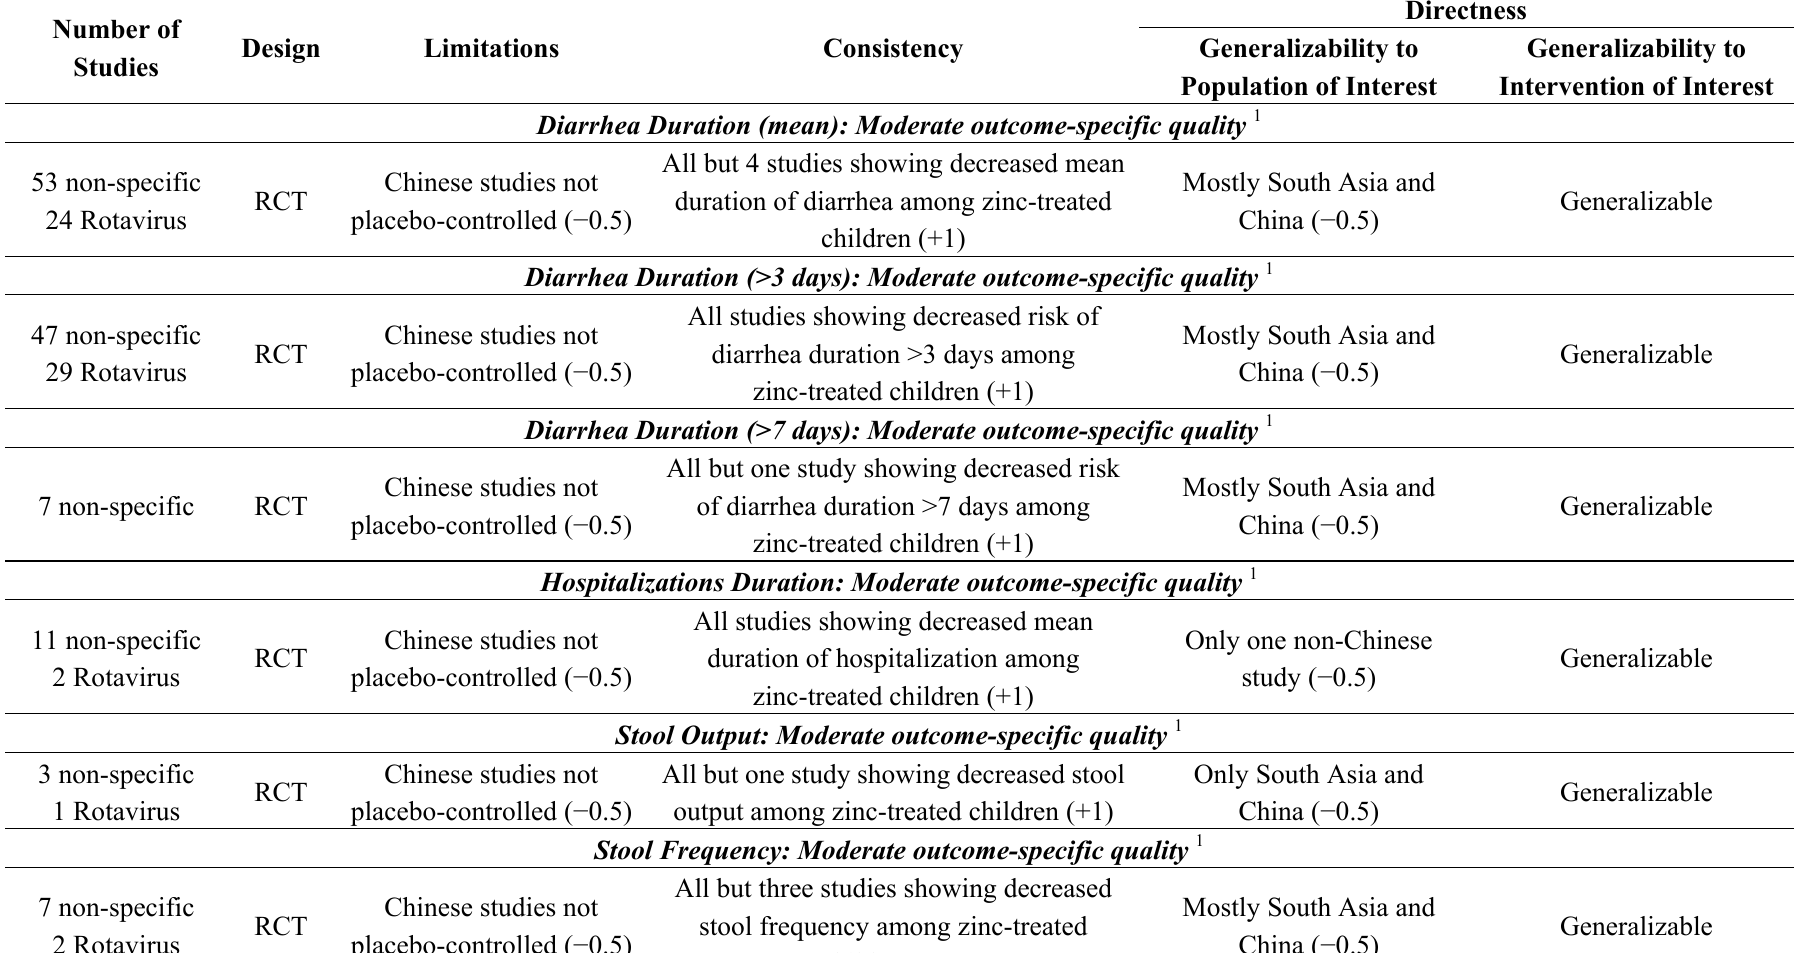
Table 6. Quality assessment of studies measuring the association between therapeutic zinc supplementation and selected